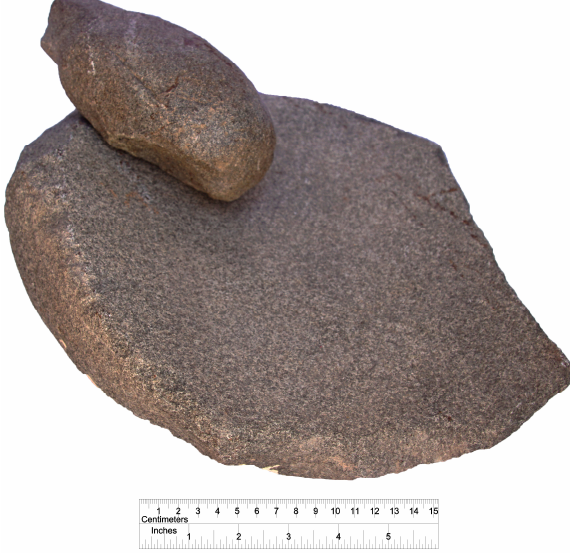
Figure 9. A millstone and grinding tool (Image by Athanasios K. Vionis).